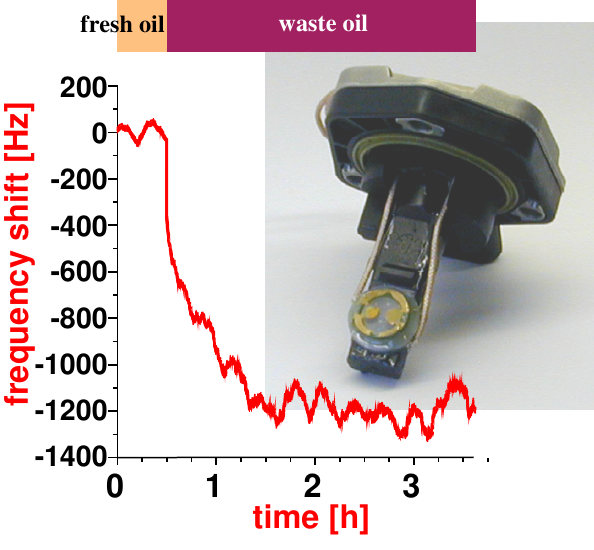
Figure 5: Commercial oil level probe with mounted sensor and frequency response of the system on the change from fresh oil to waste